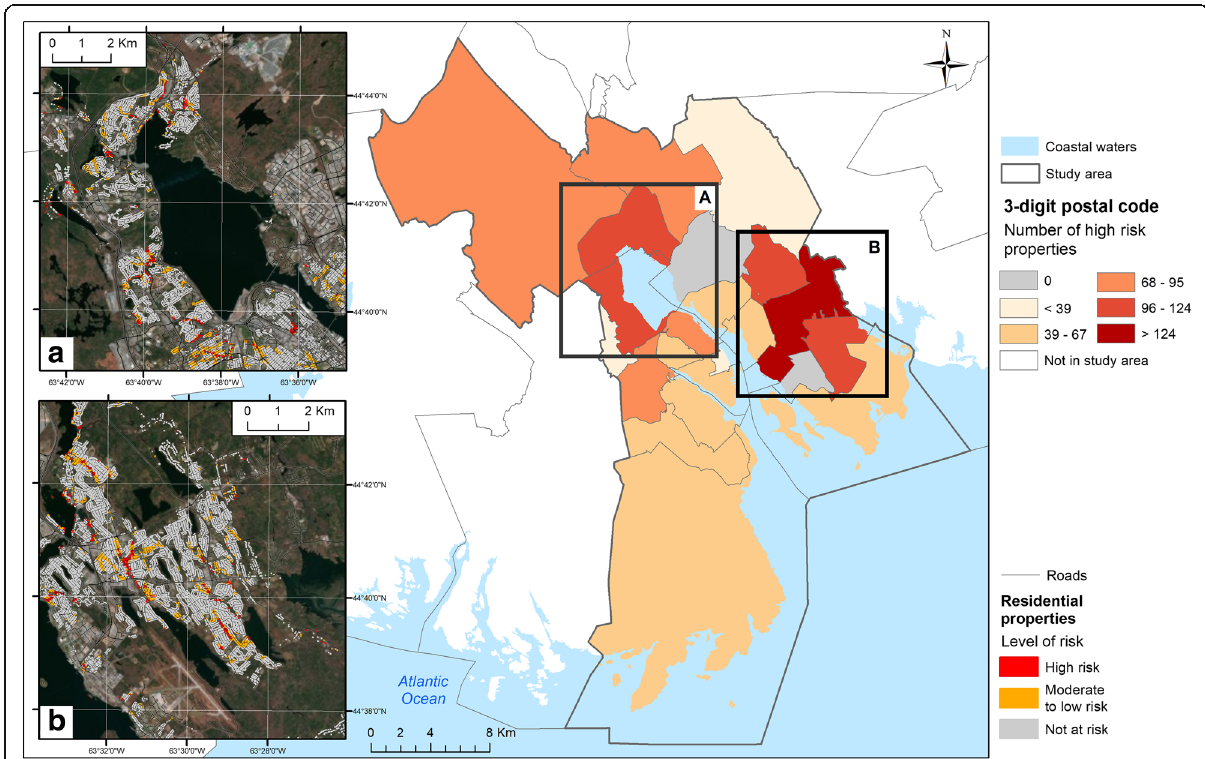
Fig. 2 Spatial distribution of flood risk in the study area. Map insets a and b show the location of residential properties at risk of flooding in parts of